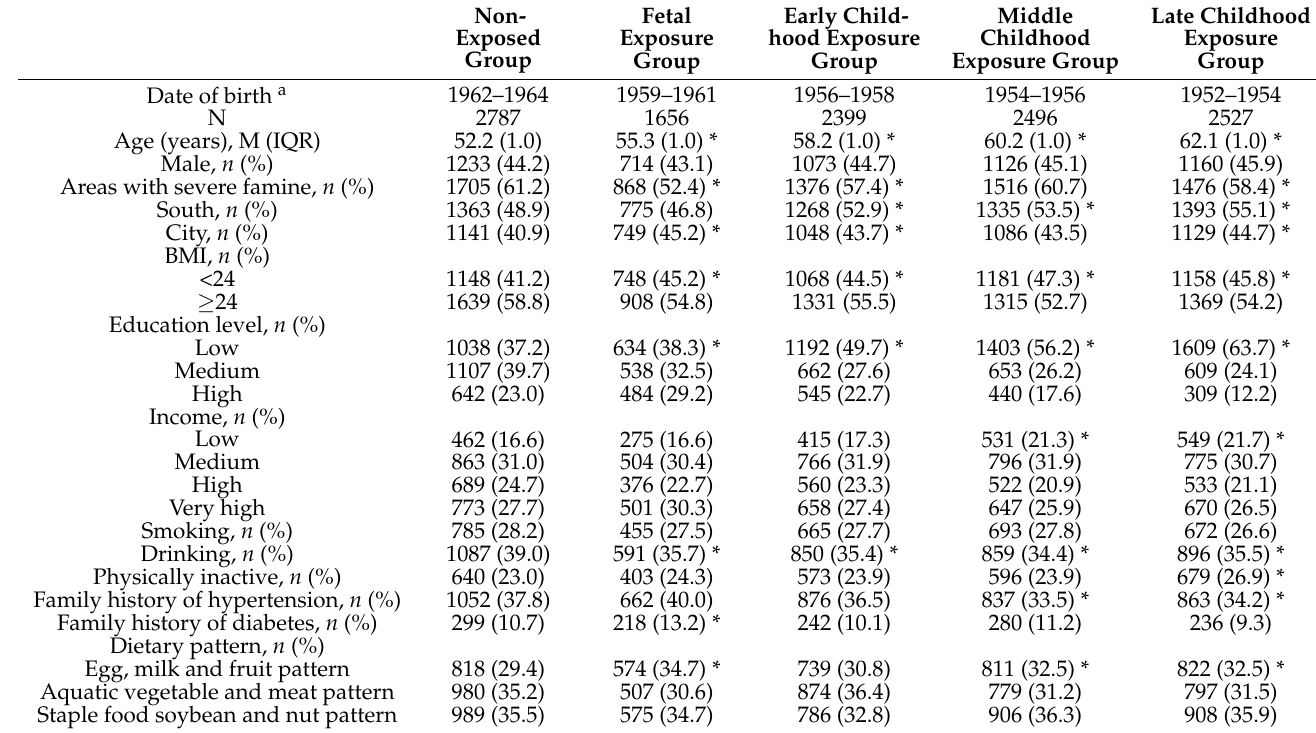
Table 1. General characteristic distribution in the study population.